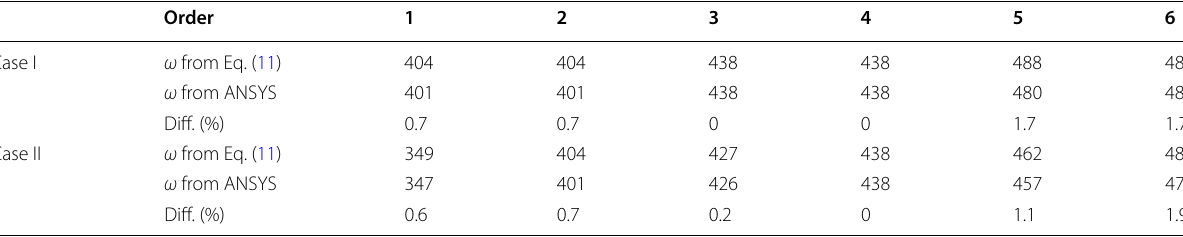
Table 2 Natural frequencies of cylindrical shell with tuned bolted joints (Hz) Order 1